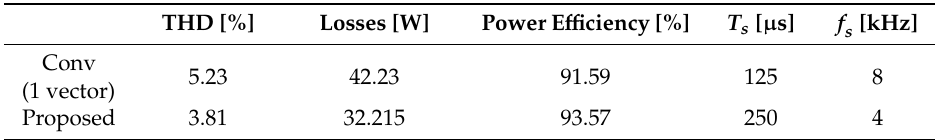
Table 4. Performance comparison between the conventional method and the proposed method in experimental